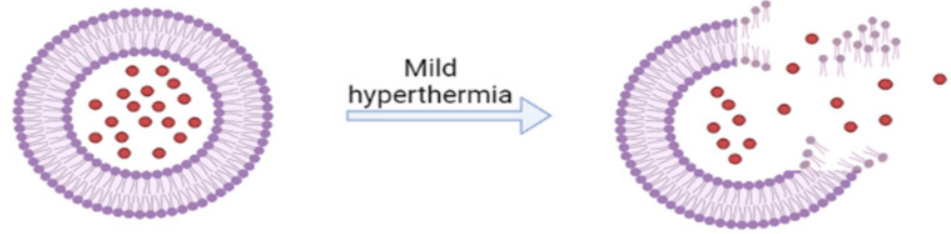
Figure 12. Schematic representation of temperature-sensitive liposomes. Created with BioRender.com (accessed on 10 January